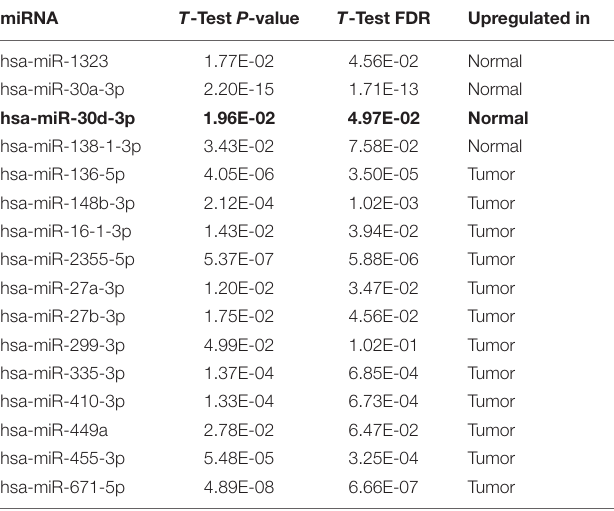
TABLE 5 | Downregulated/upregulated miRNA in LUAD from TCGA. miRNA T -Test P -value T -Test FDR Upregulated in hsa-miR-1323